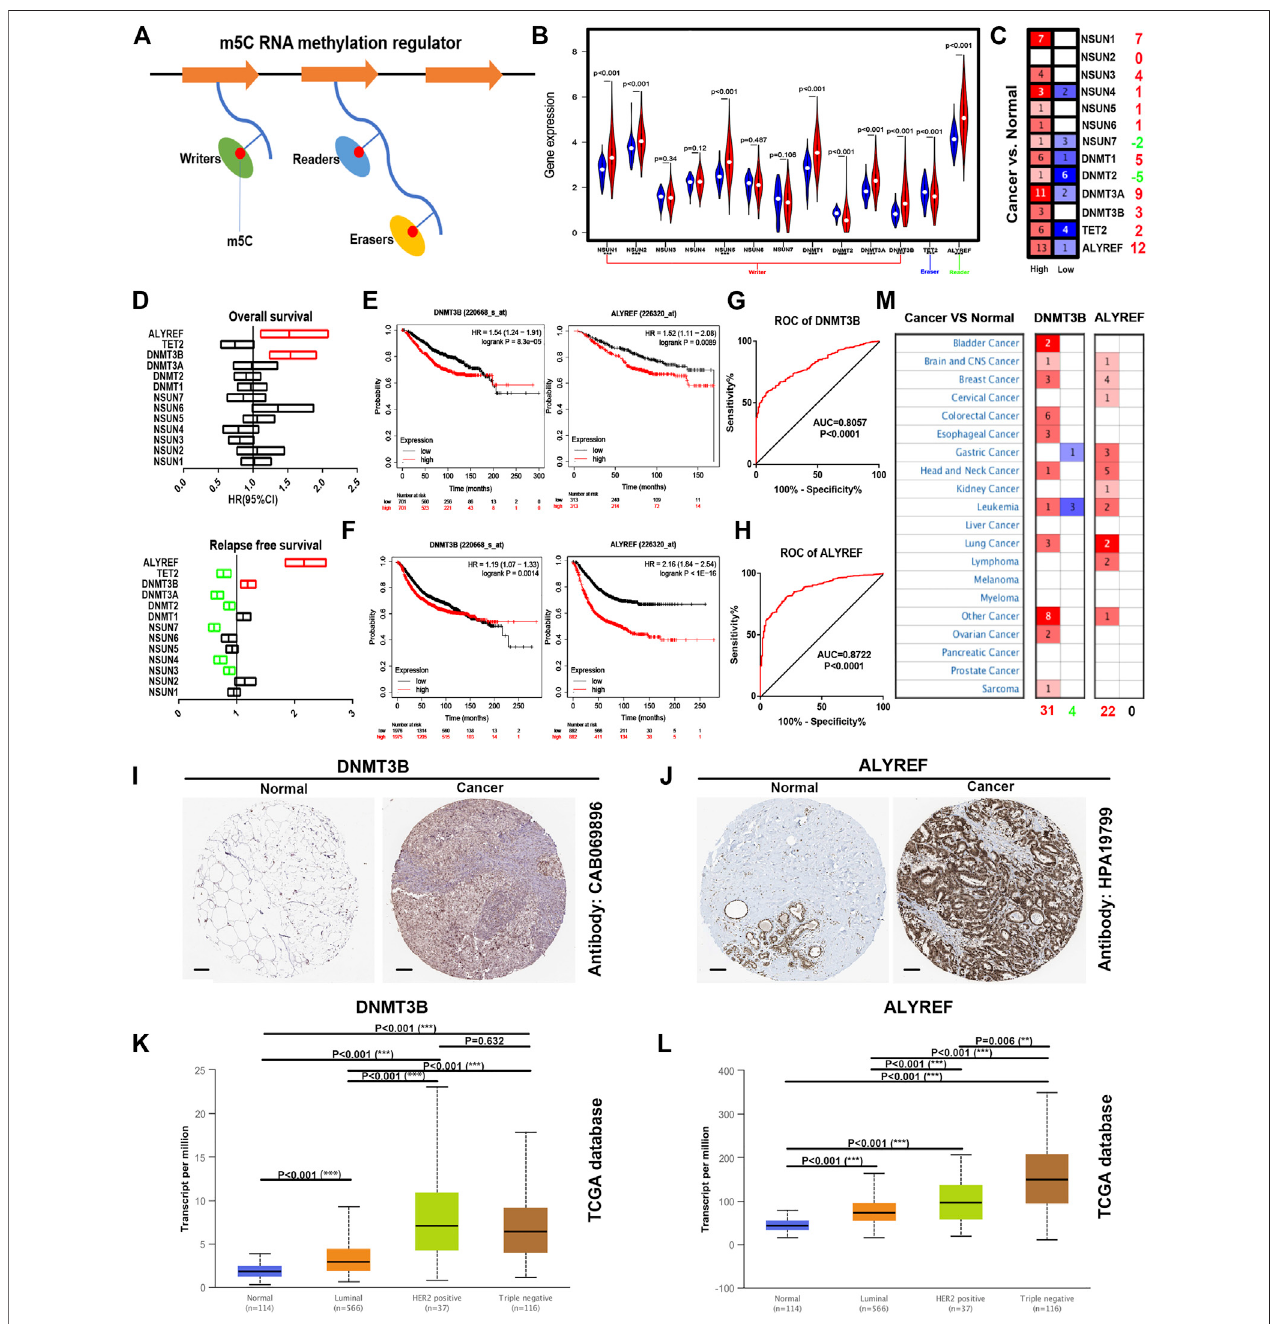
FIGURE 1 | Overview of expression, diagnostic, and prognostic values of m 5 C regulators in breast cancer. (A) Diagram of m 5 C regulators. (B) Expression of m 5 C regulators in TCGA breast cancer cohort. Blue: normal samples; red: cancer samples. (C) Expression of m 5 C regulators determined by the Oncomine database. (D) Survivalanalysis(includingoverallsurvivalandrelapse-freesurvival)form 5 CregulatorsinbreastcancerusingtheKaplan – Meierplotter. (E) PrognosticvaluesofDNMT3B in breast cancer. (F) Prognostic values of ALYREF in breast cancer. (G) ROC curve of DNMT3B in breast cancer. (H) ROC curve of ALYREF in breast cancer. The protein level ofDNMT3B (I) or ALYREF (J) inbreast cancer detected byHuman ProteinAtlas database. Scale bar: 100 um. (K) Expression of DNMT3B in breast cancer among various stages. (L) Expression of ALYREF in breast cancer among various stages. (M) (I) Expression of DNMT3B and ALYREF across different cancer types by the Oncomine database. ** p < 0.01; *** p < 0.001.